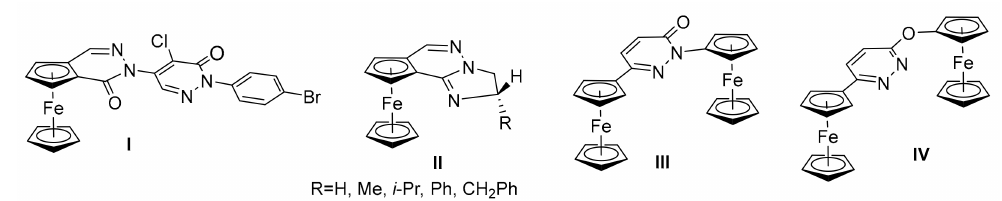
Figure 1. Ferrocene-containing pyridazine derivatives displaying antiproliferative effects on human malignant cell lines.